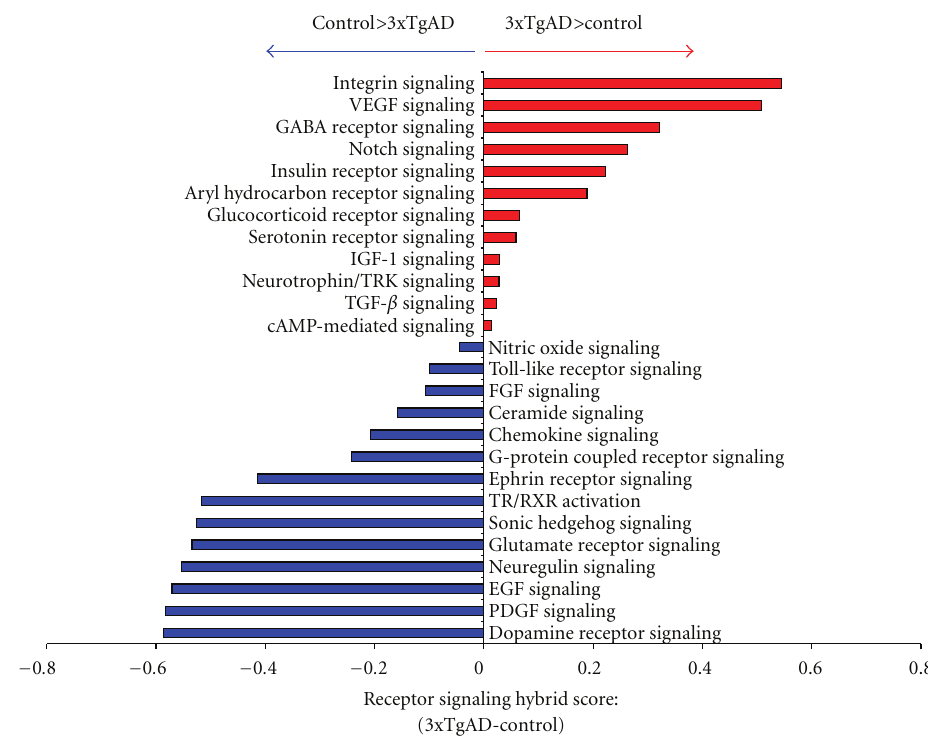
Figure 5: Functional receptor signaling pathway informatic clustering of control and 3xTgAD lipid raft proteins. Subtractive representation of hybrid score generation after clustering of raft proteins from control and 3xTgAD animal rafts into receptor signaling pathways. The data is presented as a numerical value of the control pathway hybrid score subtracted from the 3xTgAD pathway hybrid score. Pathways in which the score in 3xTgAD was greater than the control are denoted in red; pathways in which the control hybrid score was greater than the 3xTgAD hybrid score are denoted in